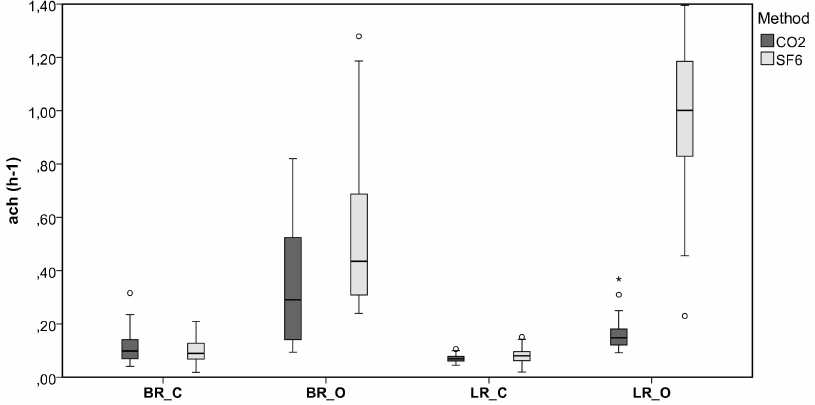
Figure 8. Air change rate using Sulfur hexafluoride (SF 6 ) and Carbon dioxide (CO 2 ) as tracer